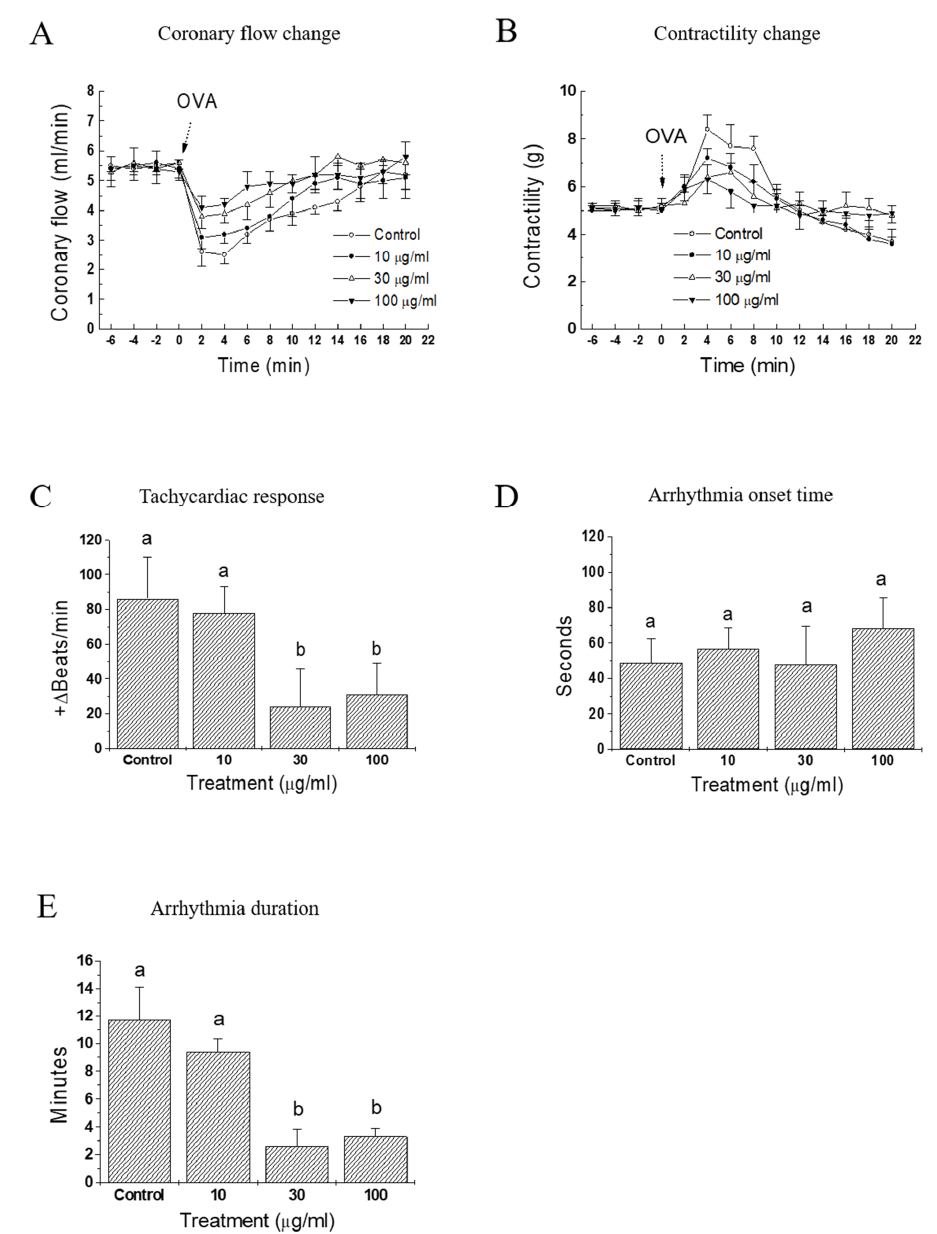
Figure 3. Effects of isoquercitrin (IQ) on cardiac anaphylaxis in isolated guinea pig hearts. ( A ) Coronary flow change, ( B ) contractility change, ( C ) tachycardiac response, ( D ) onset, and ( E ) duration time of arrhythmia were measured in OVA (1 mg)-treated isolated hearts from Hartley guinea pigs ( n = 10 per group). DMSO was used as the control. Different alphabets on bars denote significantly different means at p < 0.05. Statistical significance was not shown for clarity purpose in the coronary flow change and contractility change.